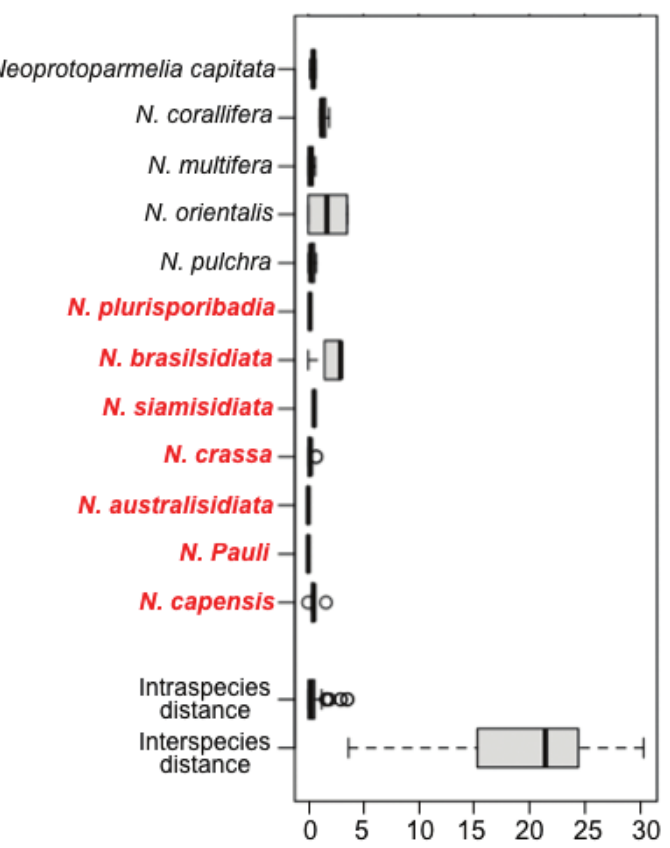
Type species. Maronina australiensis Hafellner & R. W. Rogers. Type. AUSTRALIA (Fig. 3). Queensland, Tandora about 25 km ENE of Maryborough, sea level, 25°27'S, 152°52'E, mangroves, on Rhizophora stylosa , 23 August 1986, J. Hafellner 17823 & R. W. Rogers (holotype GZU).